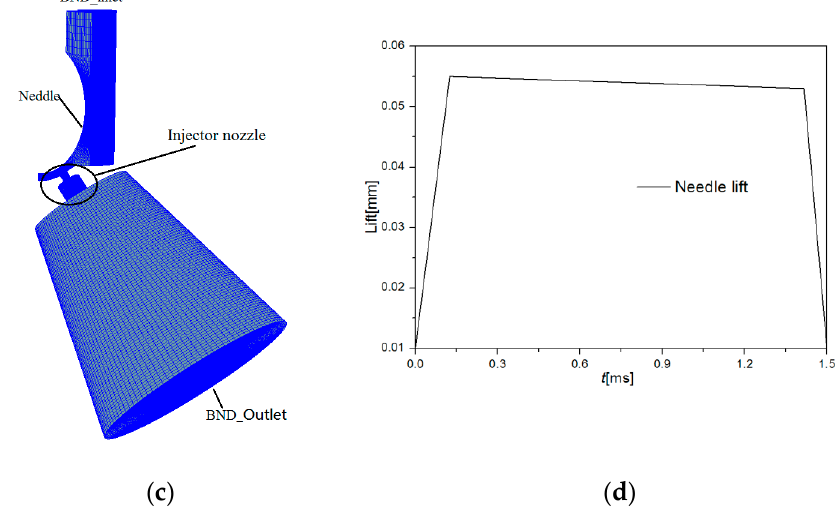
Figure 1. Simulation models. ( a ) ”Spray G” nozzle, ( b ) GDI injector head structure, ( c ) Mesh model, ( d ) Injector needle lift curve.